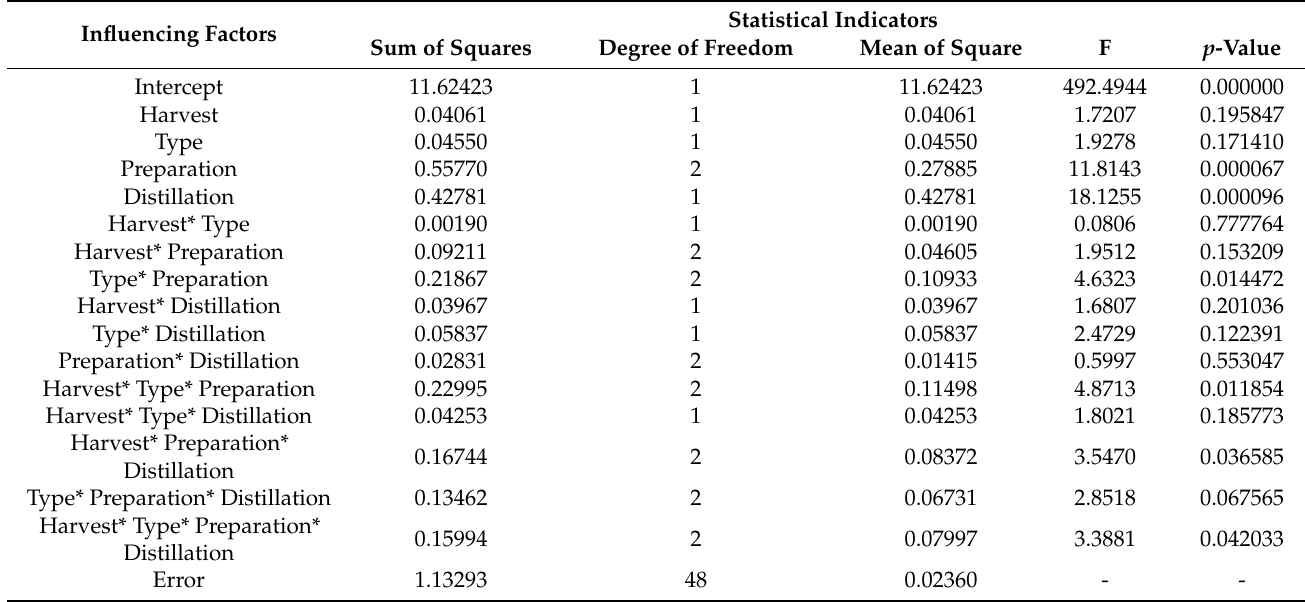
Table 2. Results of the analysis of the variance of the influence of the analyzed factors on the utilization rate of the essential oils in immortelle at a significance level of p < 0.05.